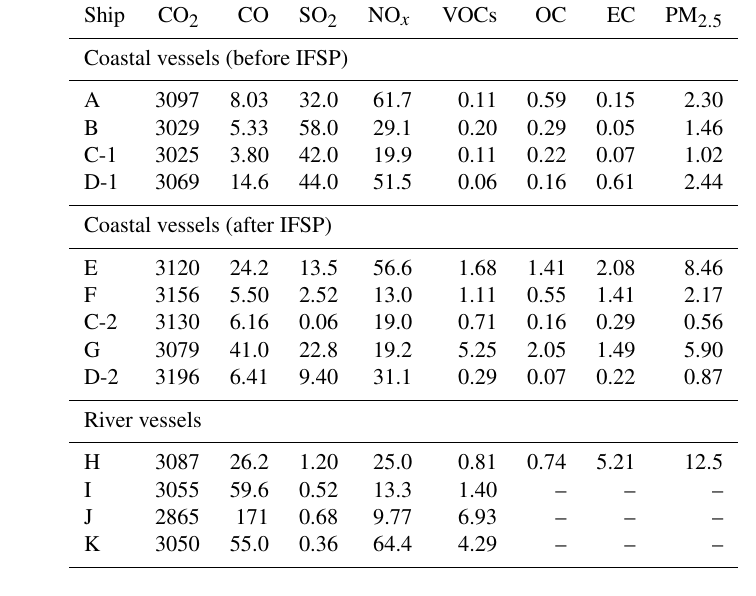
Table 2. The emission factors for test vessels (gkg − 1 ). Ship CO 2 CO SO 2 NO x